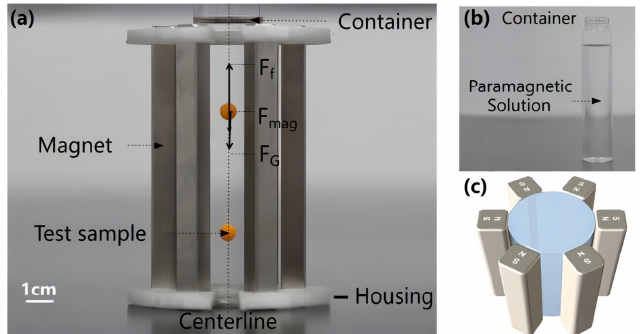
Figure 1. Overview of M-MagLev system. Photographs of ( a ) an M-MagLev system with 6 magnets and ( b ) the container in the M-MagLev system. ( c ) The corresponding simulation model of the M- MagLev system.